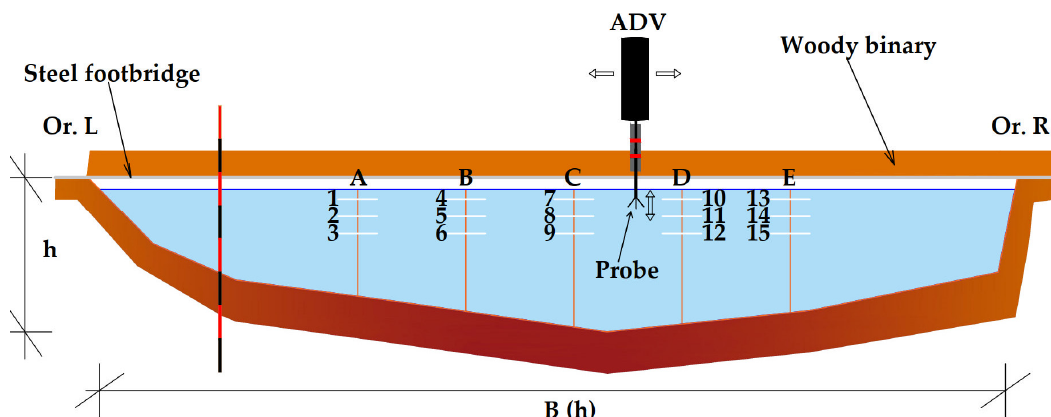
Figure 5. Scheme of the ADV measuring points (1–15), uniformly distributed along five hydrometric lines (A–E). The ADV moved along a woody binary installed on a steel footbridge, and then blocked at each measuring point during the acquisitions. The two parameters h (m) and B (m) are respectively the water level and width at bankfull of the ADV cross section, which vary according to the flow rate. The continuous dark blue line indicates the water level at bankfull. (from Errico et al. [1], modified).